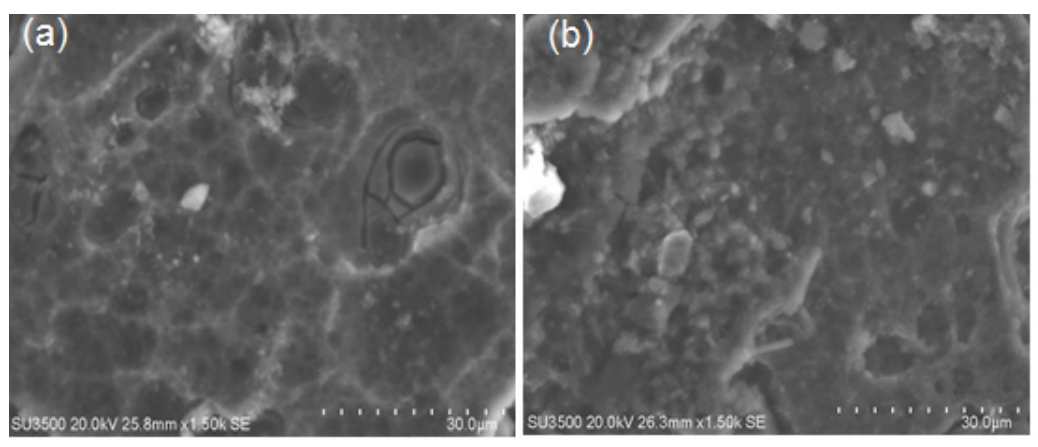
Figure 8. SEM images of ( a ) AC and ( b ) WQ Ti-6Al-4V alloy in Ringer’s solution after potentiodynamic polarization.